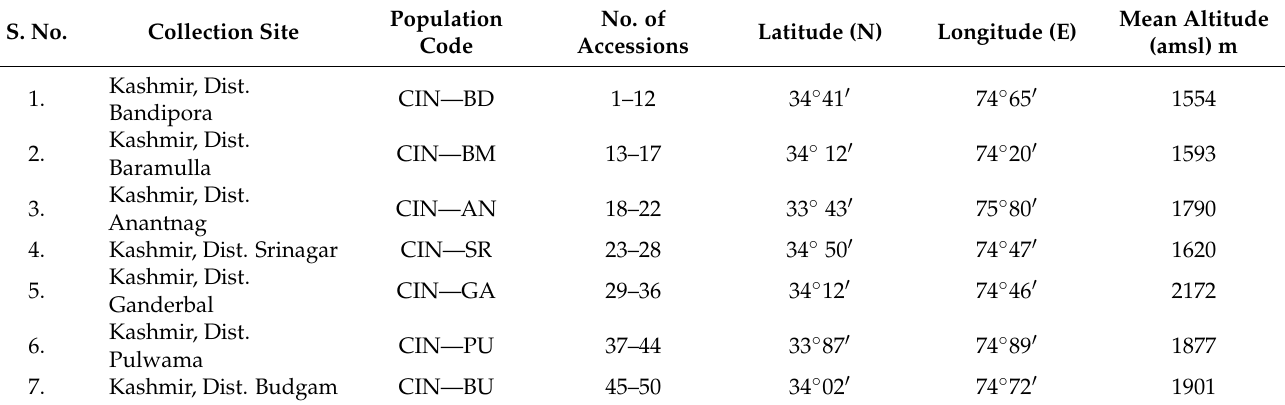
Table 1. Collection sites and the number of accessions of C. intybus L. (chicory)